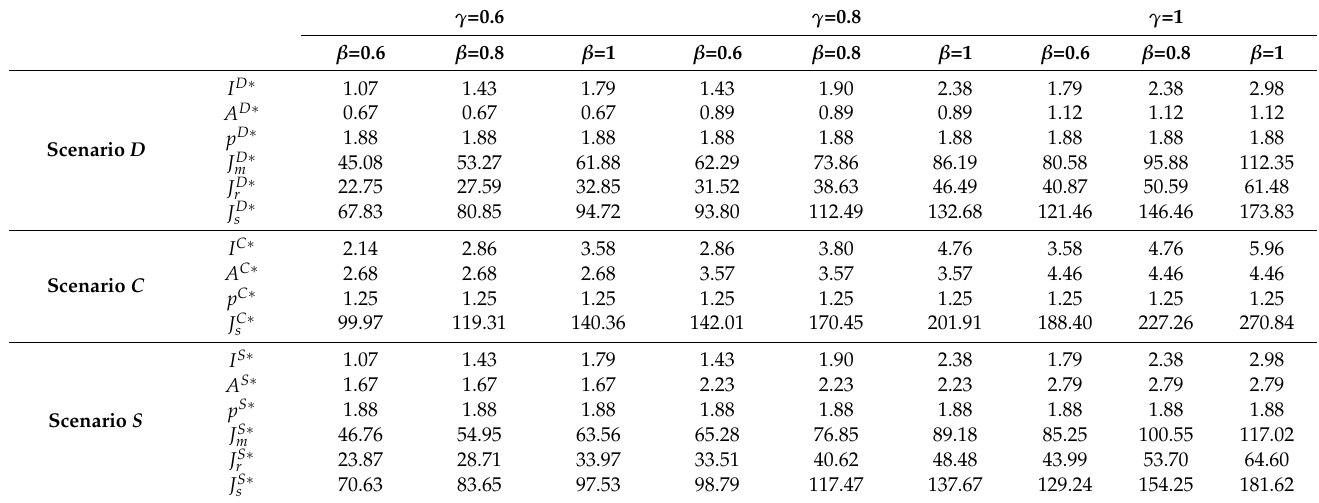
Table 3. The optimal value of decision variables and profits under different settings ( β , γ )